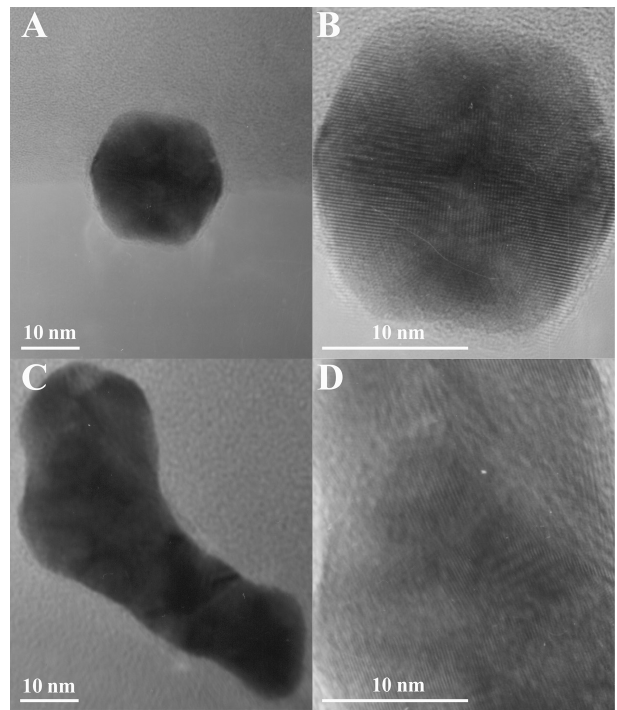
Figure 2. (A, C) TEM and (B, D) HRTEM images of the gold nanohexagons and nanoboots synthesized respectively using 0.1 and 0.02 mM D-glucose.